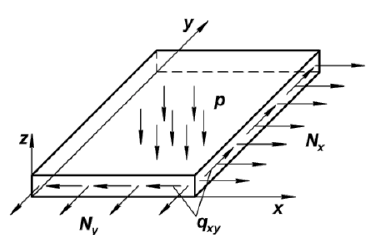
Figure 2. Aerodynamic forces represented in the form of loads that are applied to the conditional section of the aircraft wing skin. N x —longitudinal force in the plane, N y —transverse force, q xy — tangential force flow, and p—pressure, perpendicular to the plane.